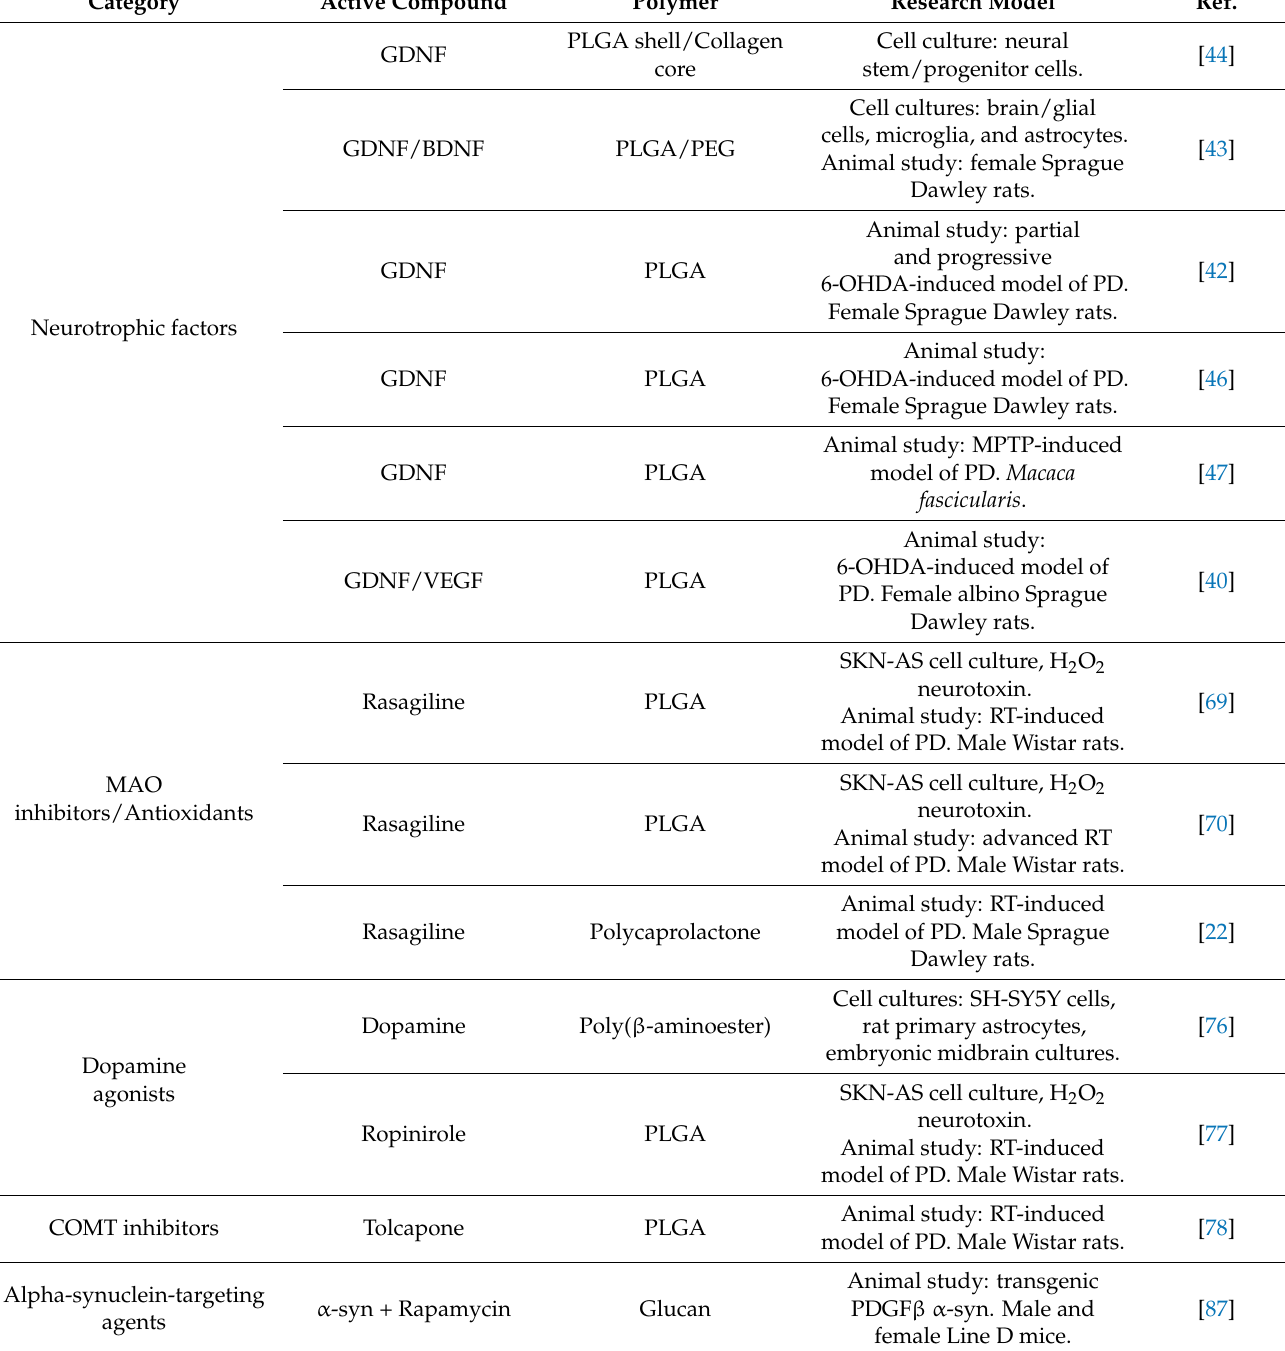
Table 1. Polymeric microparticulate systems under investigation for the treatment of